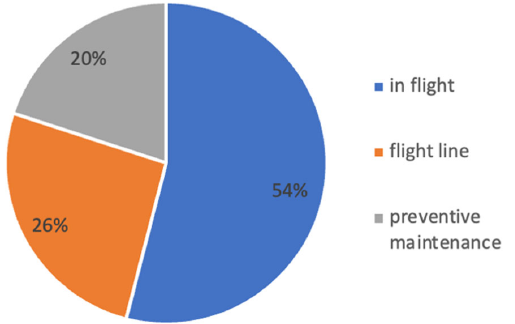
Figure 1. Percentage distribution of faults according to detection place.